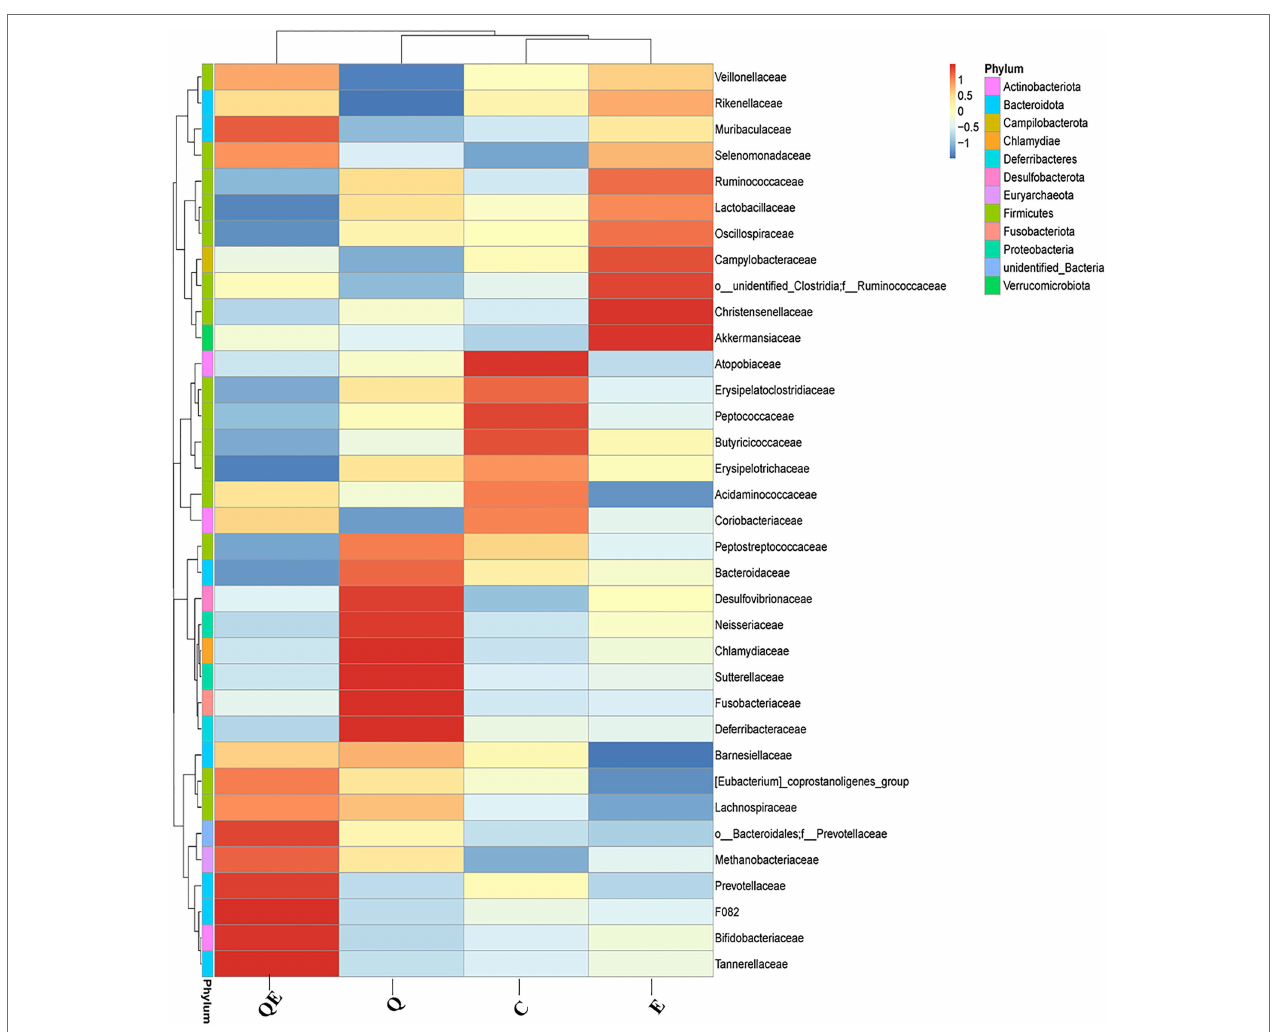
FIGURE 3 | Cecal microbiota composition and diversity at the phylum and family levels among the aged breeder chickens fed with quercetin (Q), vitamin E (E), and QE compared with the control group (C) by phylogenetic relationship and weighted unifrac distance between OTUs. The legend for color intensity of family and phylum are given on the right-hand side of the heatmap clustering